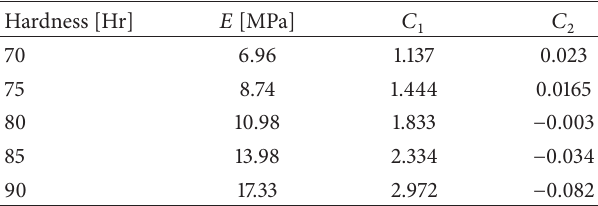
Table 1: Physical parameters of different hardness.